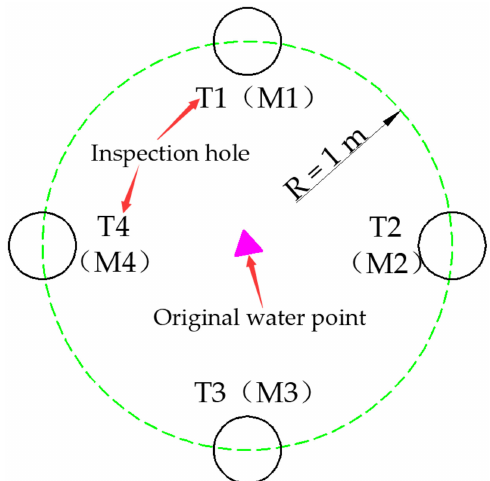
Figure 23. Check hole layout.